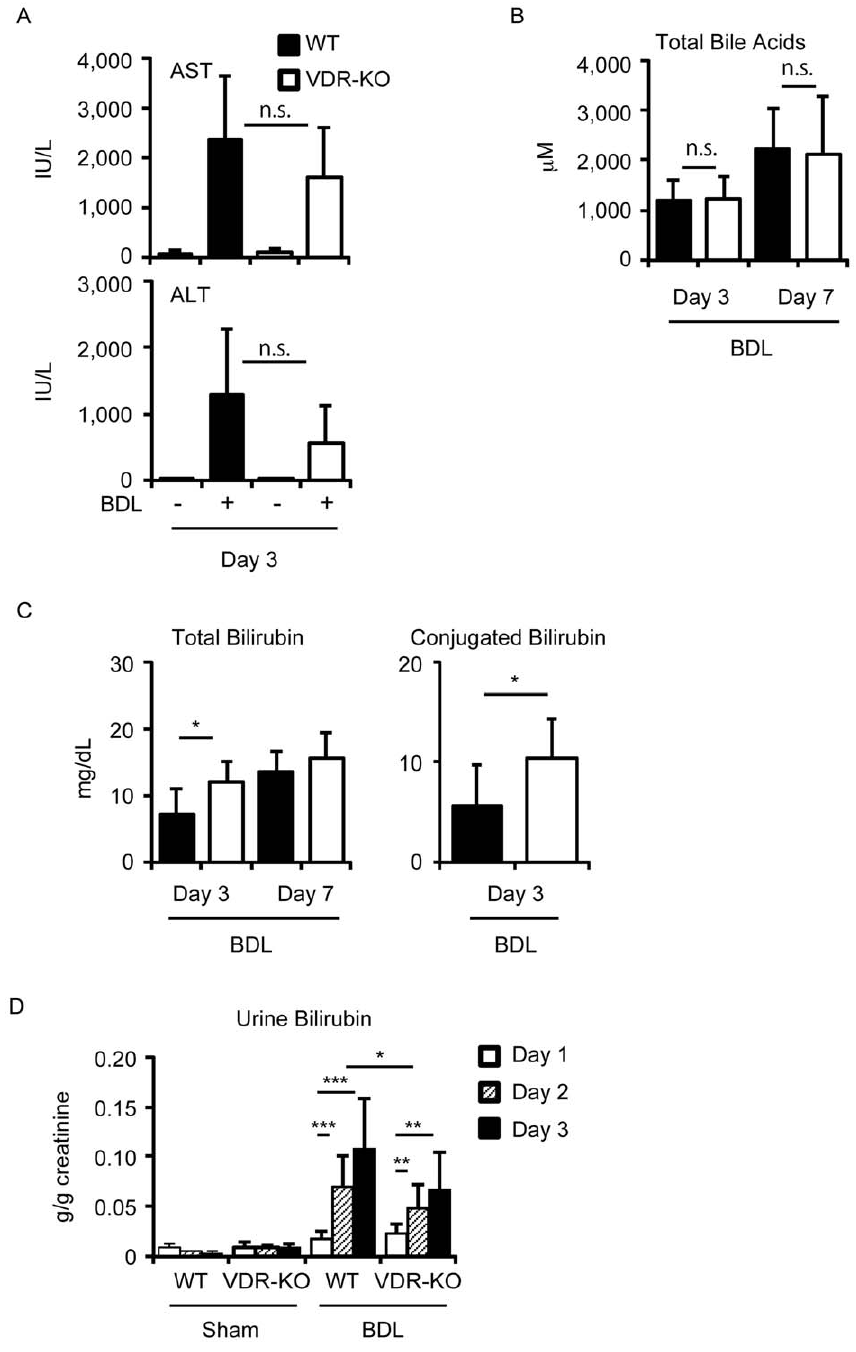
Figure 1. Effect of VDR deletion on plasma transaminases, total bile acids and bilirubin levels. (A) AST and ALT. (B) Total bile acids. (C) Total and conjugated bilirubin levels. Wild-type mice (WT) and VDR-null mice (VDR-KO) (n=4–8 per group) were subjected to sham operation or BDL and plasma samples were collected 3 days and 7 days after surgery. (D) Urine bilirubin levels. Twenty-four-hour urine samples were collected 1 day, 2 days and 3 days after surgery and subjected to total bilirubin measurement. The values represent means 6 S.D. * p , 0.05; ** p , 0.01; *** p , 0.001. n.s., not significant.